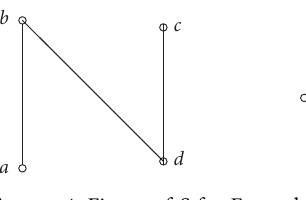
Figure 4: Figure of S for Example